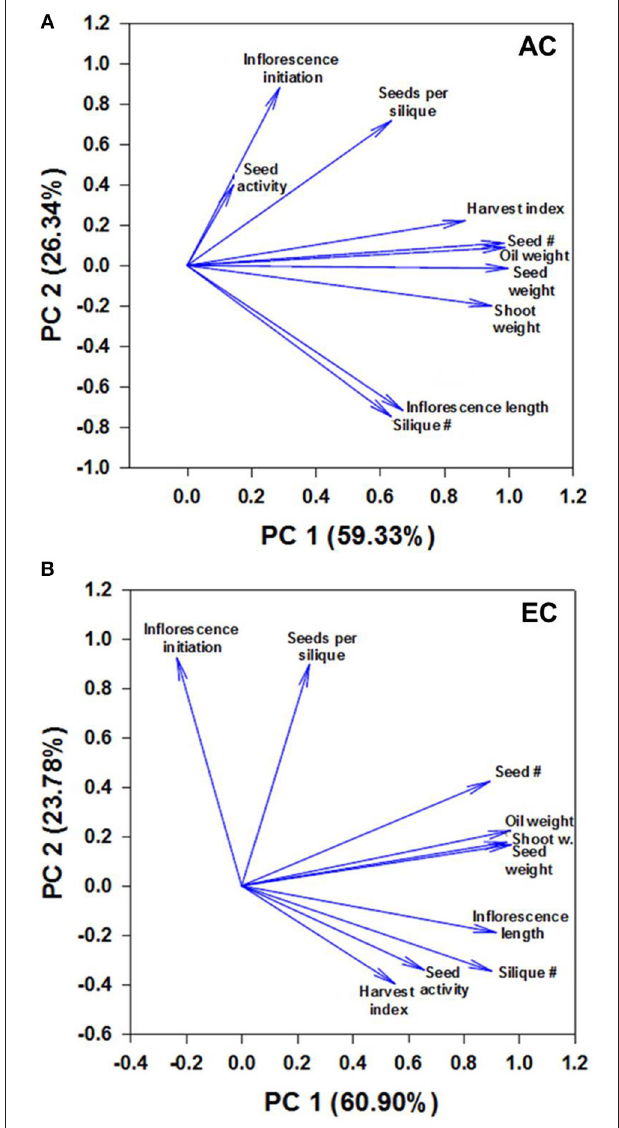
FIGURE 6 | Component loading plot of growth variables determined by principal component analysis. Relationships between measured growth characteristics and between these characteristics and seed mtPDH activity at AC (A) and EC (B) in the space of the two components are presented. PC1 and PC2 are principal components 1 and 2, respectively, and the value within the parenthesis is the percentage contribution of each axis to the total variation. The lengths of the arrows or vectors indicate the strength of the correlations of variables with PC1 and PC2. For plants grown under AC and EC, the component loadings plots showed that the greatest contribution to the values of the first two components was from total seed dry weight, total oil weight, total seed number, and total shoot dry weight as these variables displayed the longest eigenvectors. Smaller the angle between the vectors, stronger the relationship between variables. Moderately large angles between vectors of plotted variables indicate moderate correlations while very large angles between vectors indicate that the corresponding variables are least correlated. The other parameters shown include days to inflorescence initiation, seed mtPDH activity, seed harvest index, 100-seed weight, total inflorescence length and total silique number. The component scores plot is given in Supplementary Figure